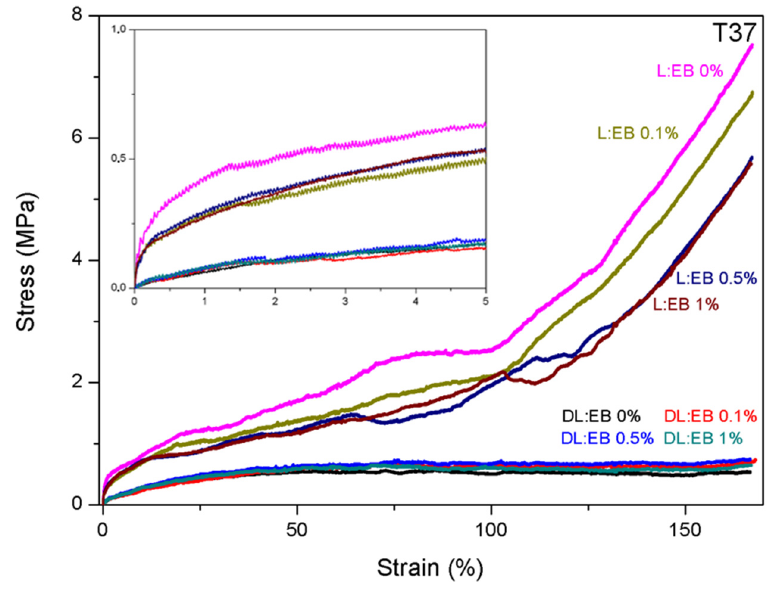
Figure 3. Mechanical properties of DL:EB and L:EB copolymers with different % of CNTs at body temperature (T37). temperature